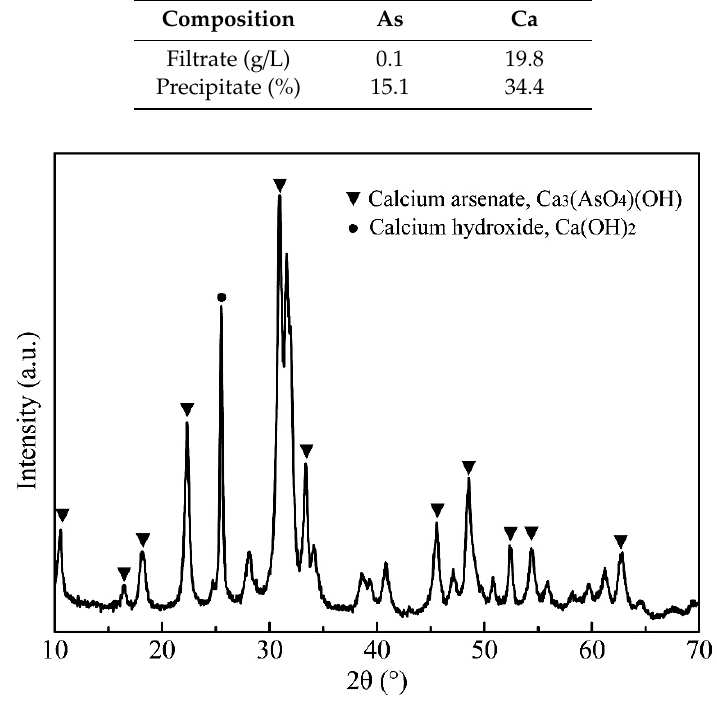
Table 6. The chemical analysis of filtrate and precipitate.